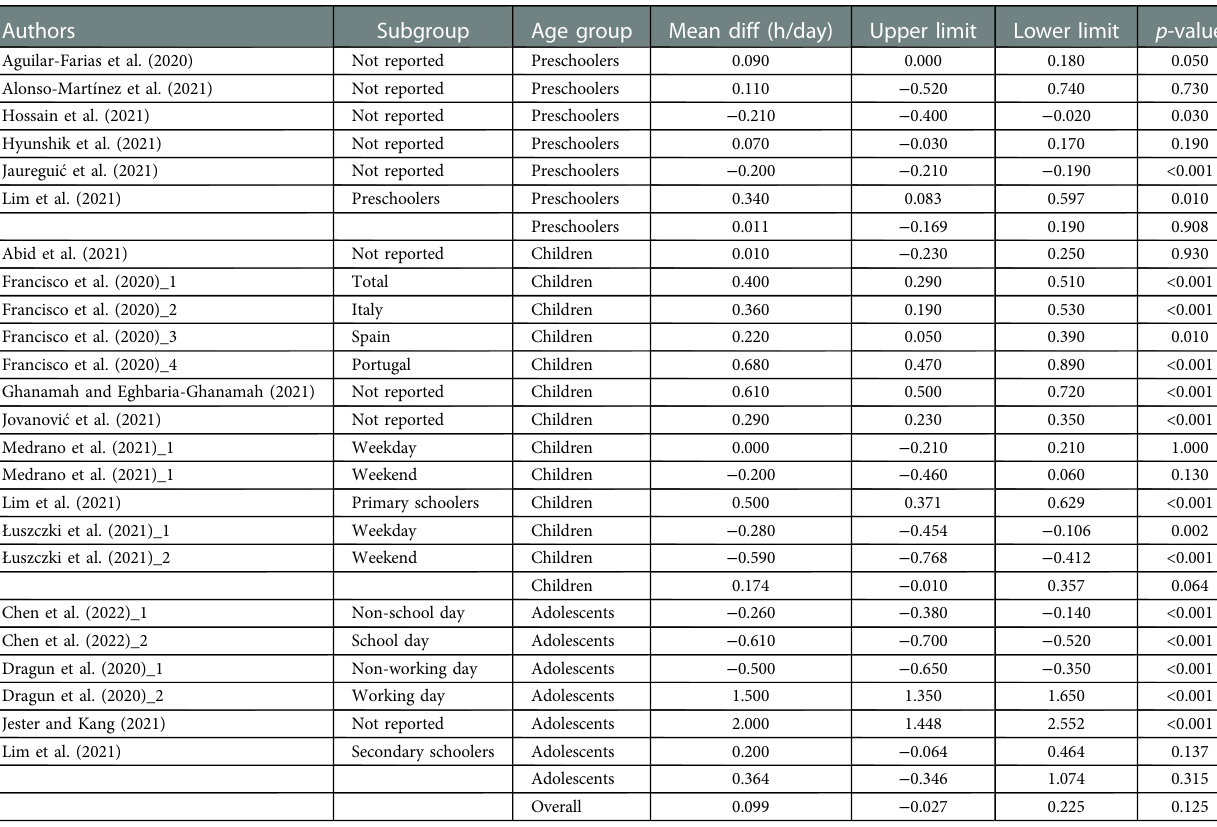
TABLE 3C Outcomes: the mean time change in sleep duration before and during